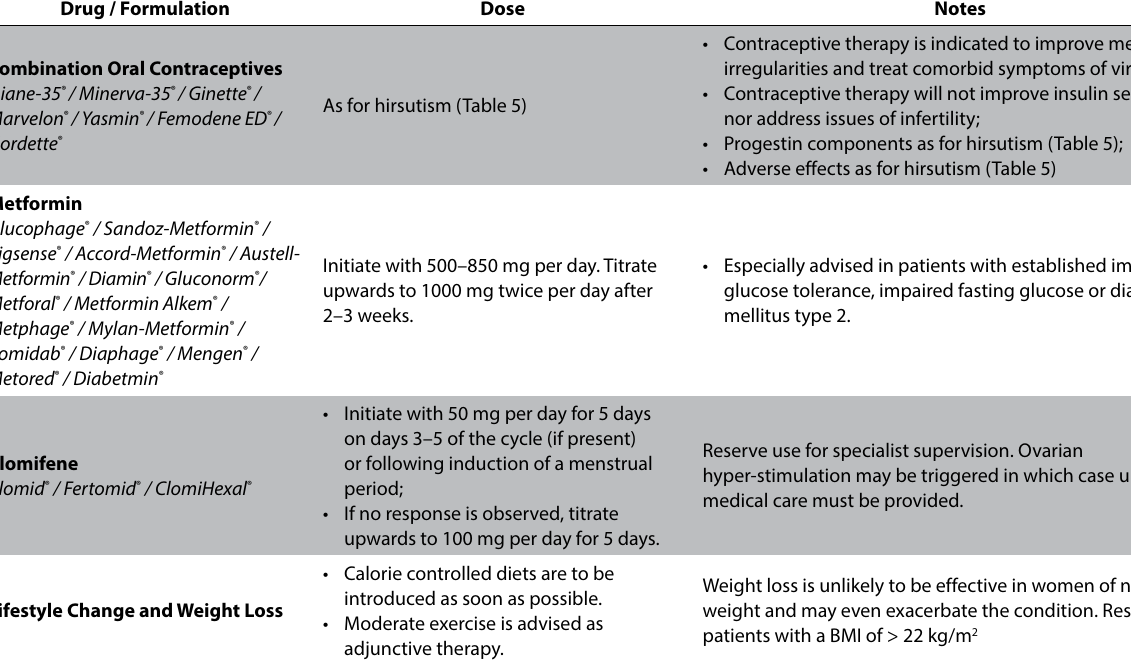
Drug / Formulation